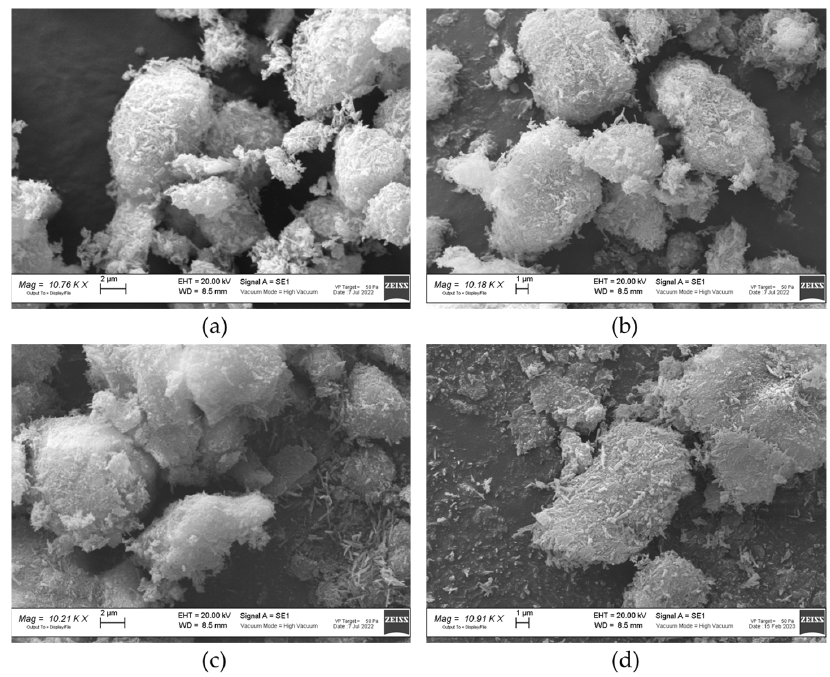
Figure 6 . SEM images at 10 kX magni fi cation of H ( a ), H_H 2 SO 4 _0.5M ( b ), H_HCl_8M ( c ), and Figure 6. SEM images at 10 kX magnification of H ( a ), H_H 2 SO 4 _0.5M ( b ), H_HCl_8M ( c ),